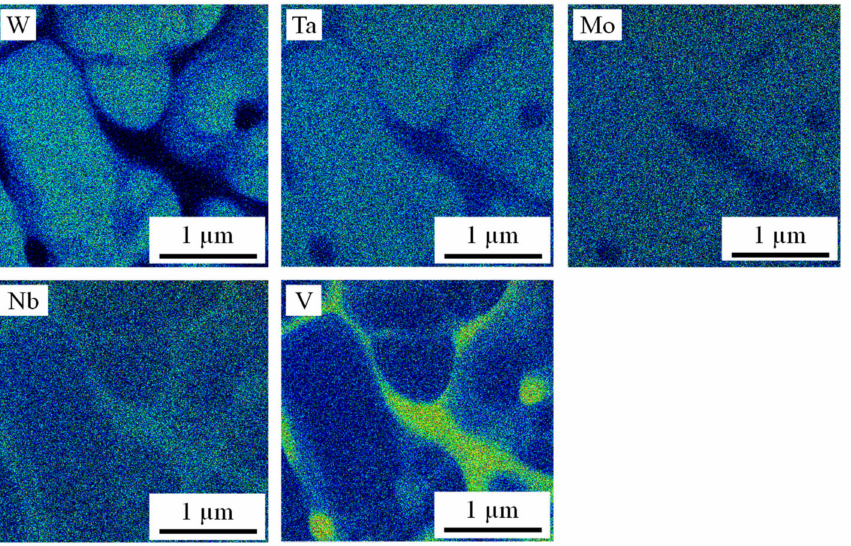
Figure 8. Qualitative TEM-EDS measurements showing the element distribution in a PBF-LB/M A